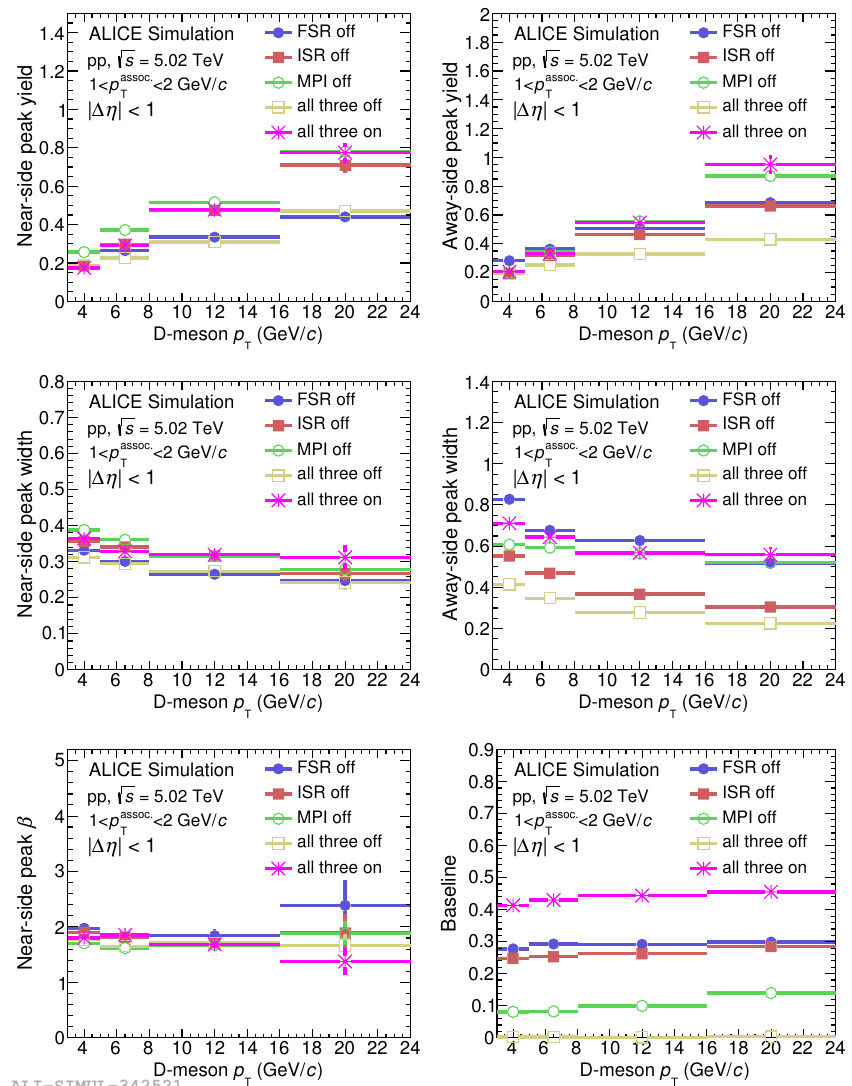
Figure 1. Near- and away-side peak yield ( top row ), width ( middle row ), β parameter and baseline ( bottom row ) of D–h correlations from simulations with different parton level contributions in pp √ s = 5.02 TeV as a function of the D meson p T for 1 < p assoc. collisions at